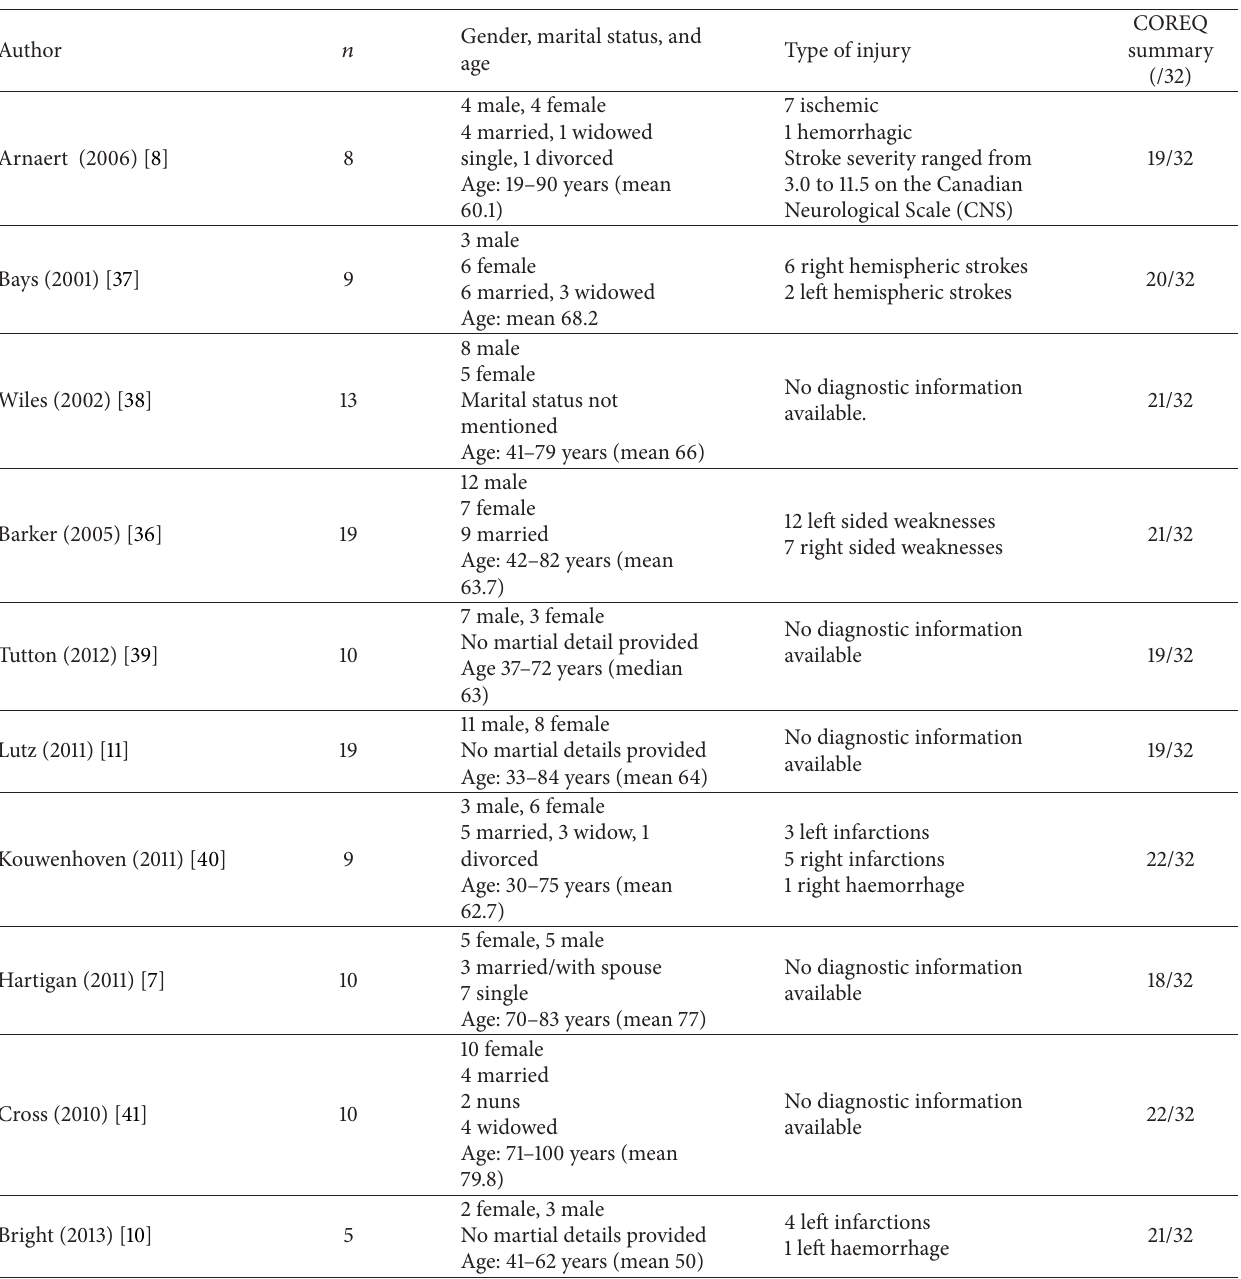
Table 1: Demographic information of individuals